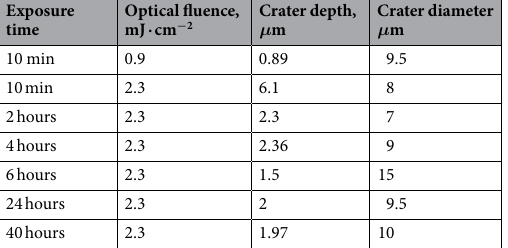
Table 1. Summary of crater geometry formed on SWNT-PVA film after laser exposure.